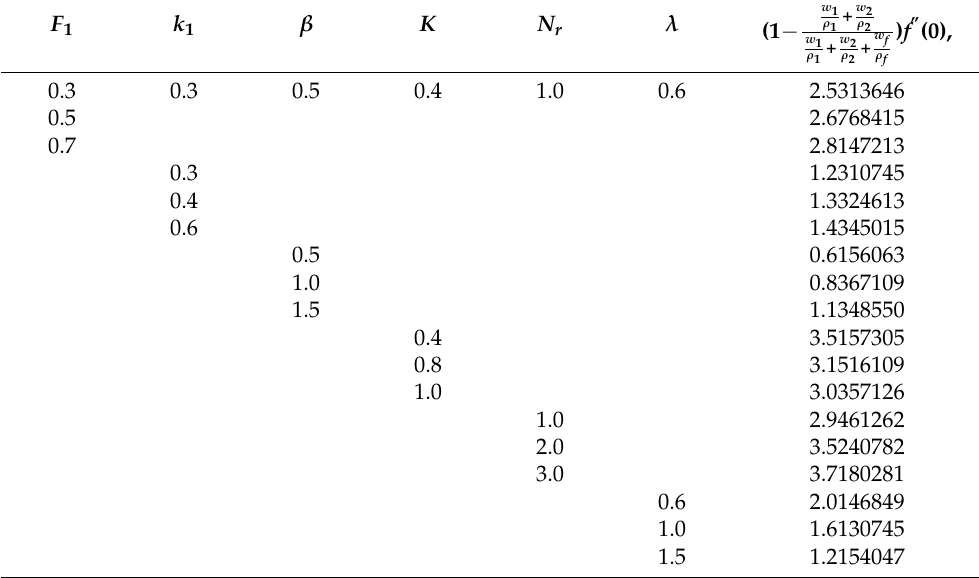
of different physical parameters. The impact of various physical parameters